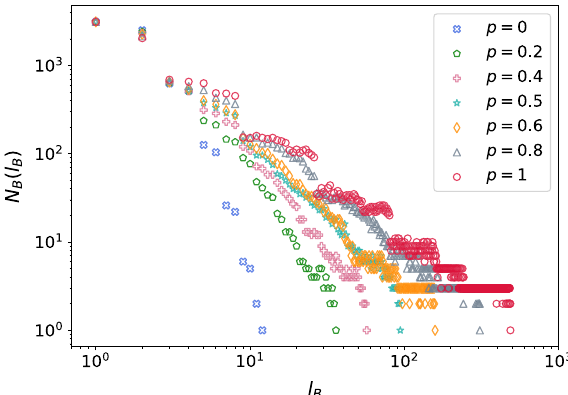
Fig. 3 Illustration of the fractality of the Song‑Havlin‑Makse model for different parameter settings. The iteration number is set to 5, parameter m is fixed to 2, and only parameter p is taking different